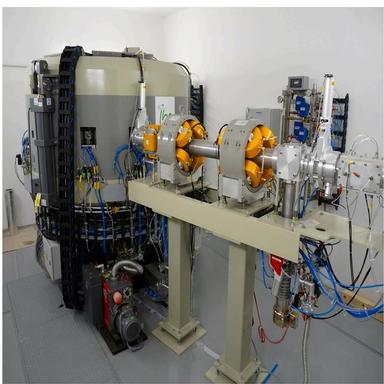
Cyclotron IBA used in measurements. The beamline serves for irradiation of solid targets. In the rectangular hole left from the beamline, the end of the liquid target is visible. The detailed view of studied target in accelerator assembly is in Fig. 1.